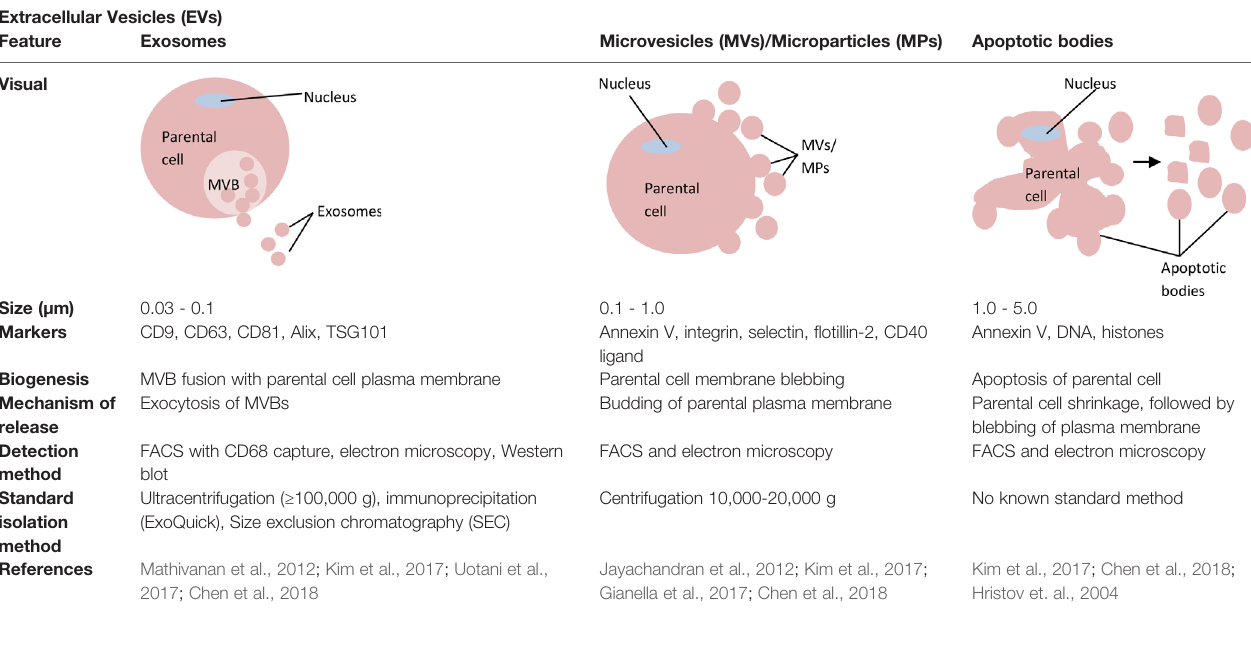
TABLE 5 | Distinctions between exosomes, microvesicles (MVs)/microparticles (MPs), and apoptotic bodies. Extracellular Vesicles (EVs)